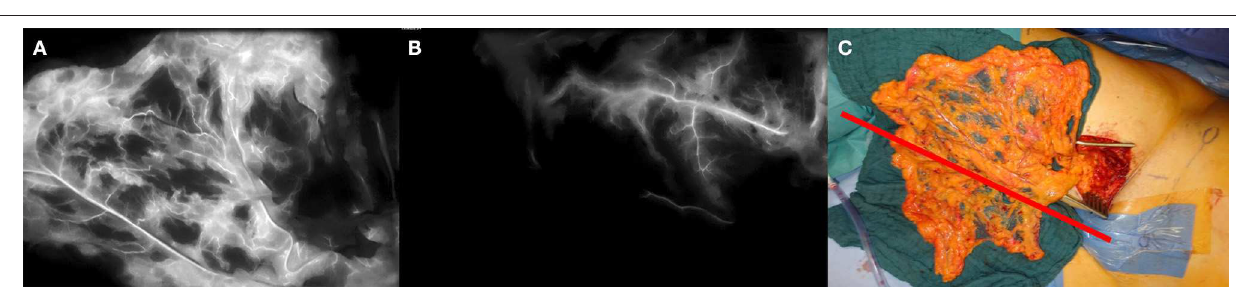
FIGURE 2 | Free omentum majus flap at the right inguinal region. (A) (left) ICG angiography of the omentum majus after anastomosis to the femoral vessels showing exact perfusion of the vessel arcades and the adjacent tissue. (B) (middle) Mal-perfused part of the omentum majus flap. (C) (right) Flap at the inguinal region after anastomosis. Red bar indicates the border between well-perfused (top) and mal-perfused (bottom) parts of the omentum majus defined by ICG